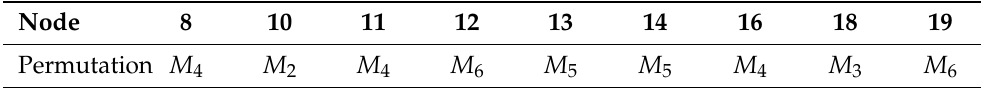
Table 3. Results of the configuration